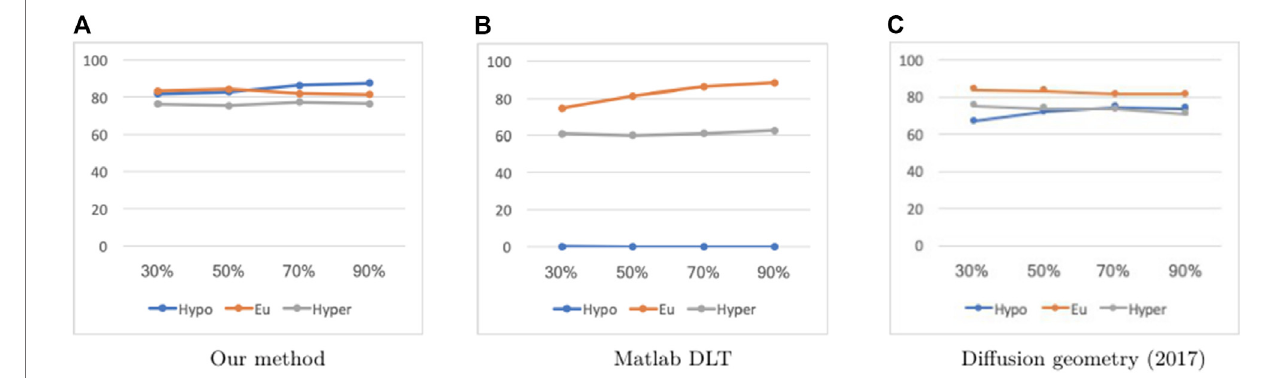
FIGURE 4 | Percentage accurate predictions and predictions with benign consequences in all three BG ranges (blue: hypoglycemia; orange: euglycemia; grey: hyperglycemia) with a 30 min prediction window on dataset J, for different training set sizes (30, 50, 70 and 90%).